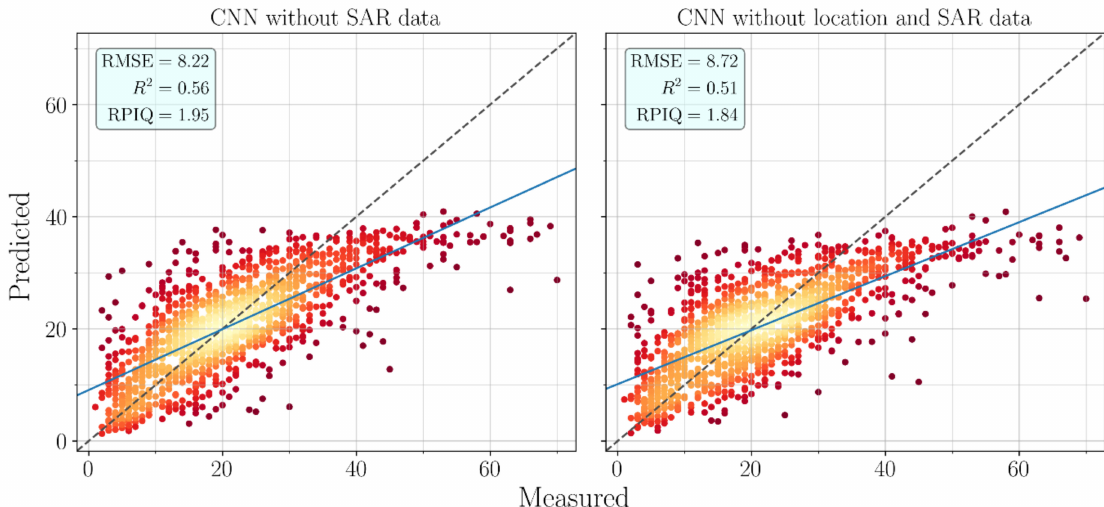
Figure A2. Goodness of fit indicating the relationship between observed and predicted clay content based on the proposed CNN model without the use of radar values; and without the use of radar values and the auxiliary input of geographical